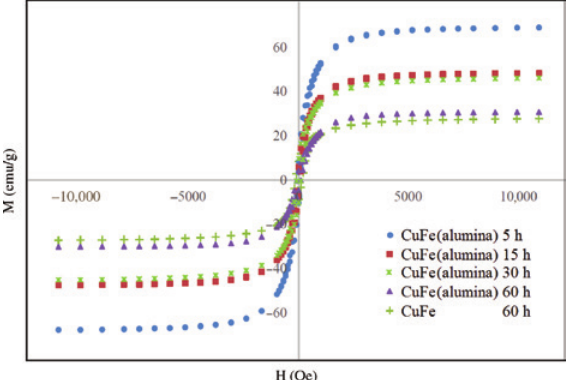
Figure 5: Magnetization versus magnetic field of CuFe alloy and CuFe(alumina) particles for different durations of mechanical